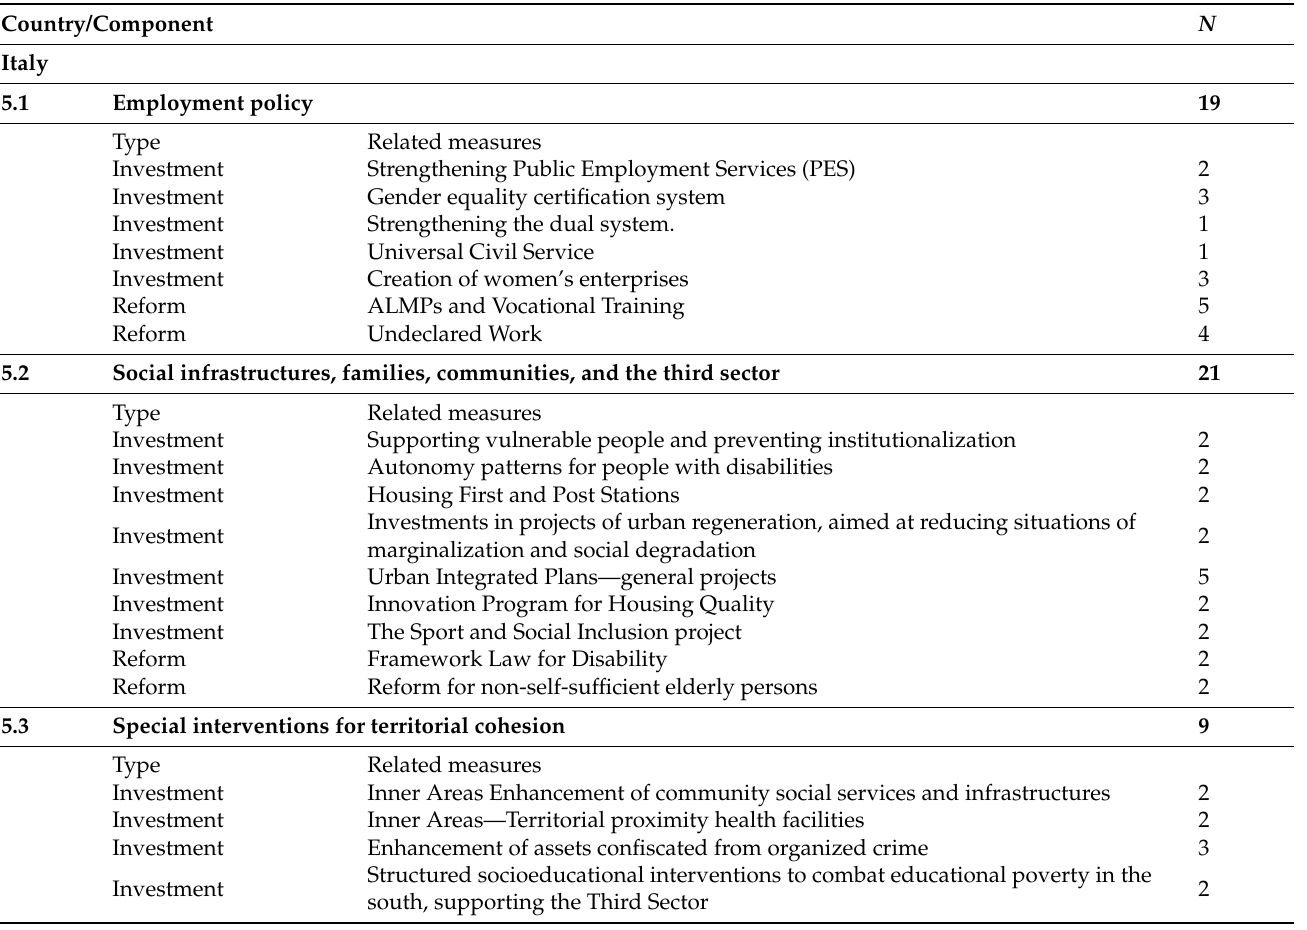
Table 6. Social and employment protection measures in the Italian recovery and resilience plan.